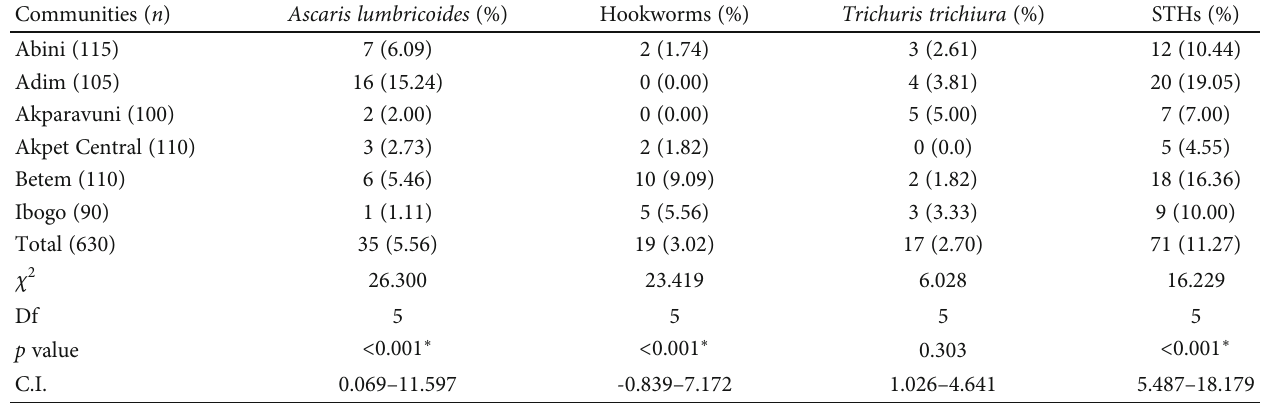
Table 3: Prevalence of STHs according to communities in Biase LGA, Cross River State. Communities ( n )